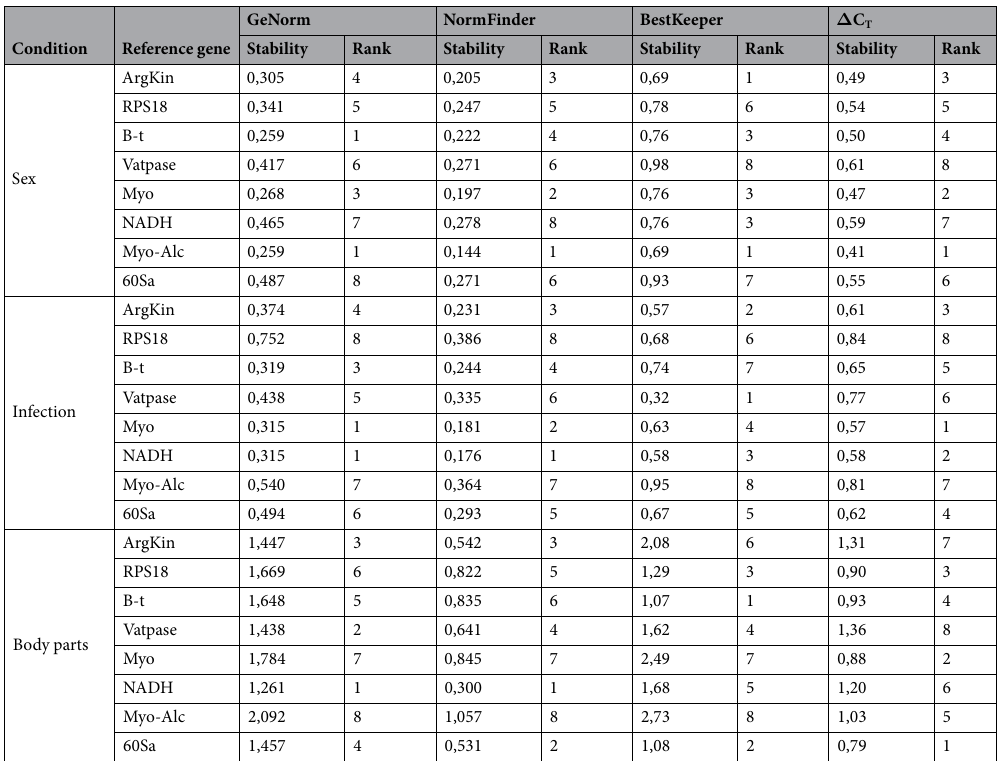
Table 3. Ranking of candidate reference genes based on stability values obtained with geNorm , NormFinder , Bestkeeper and Δ C T methods in C . littoralis